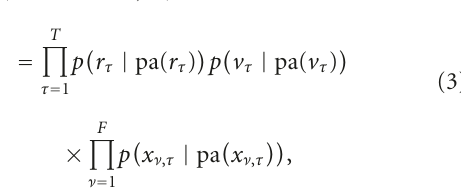
Figure 2: Graphical model of the Hidden Markov Model. This graph visualizes the conditional independence structure between the random variables and allows the joint distribution to be rewritten by utilizing (3). In the model, the nodes correspond to probability distributions of model variables, and edges to their conditional dependencies. Note that we use the plate notation for the observed variables where F distinct nodes (i.e., x ν , i where ν ∈ { 1, ... , F } ) are grouped and represented as a single node in the graphical model. In this case, F is the number or frequency bins.